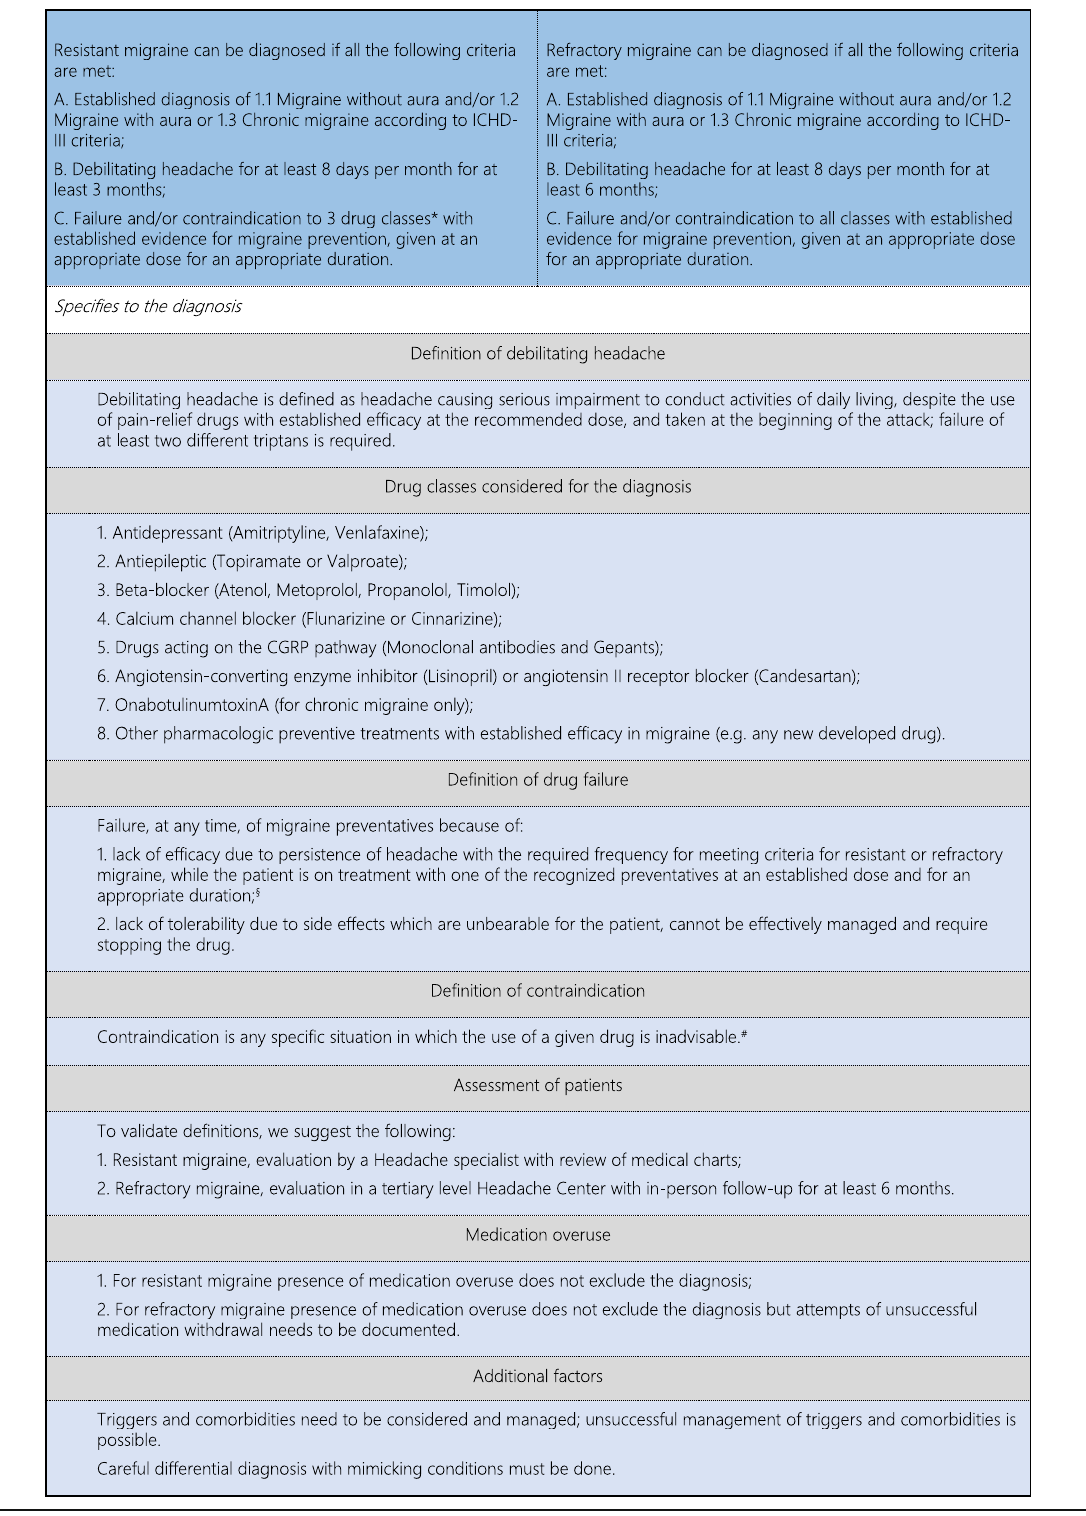
Table 3 Proposed updated definition of resistant and refractory